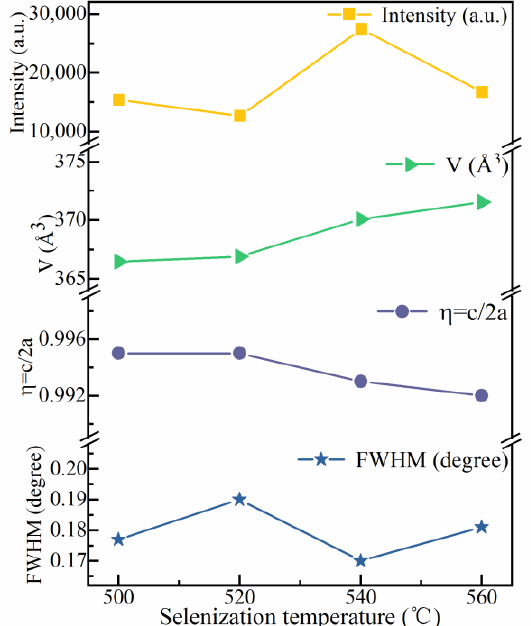
Figure 4. Curves of the FWHM and peak intensity of (112) peaks, unit cell volume (V), and lattice parameters ( η = c/2a) for the CNZTSSe films as a function of selenization temperature.